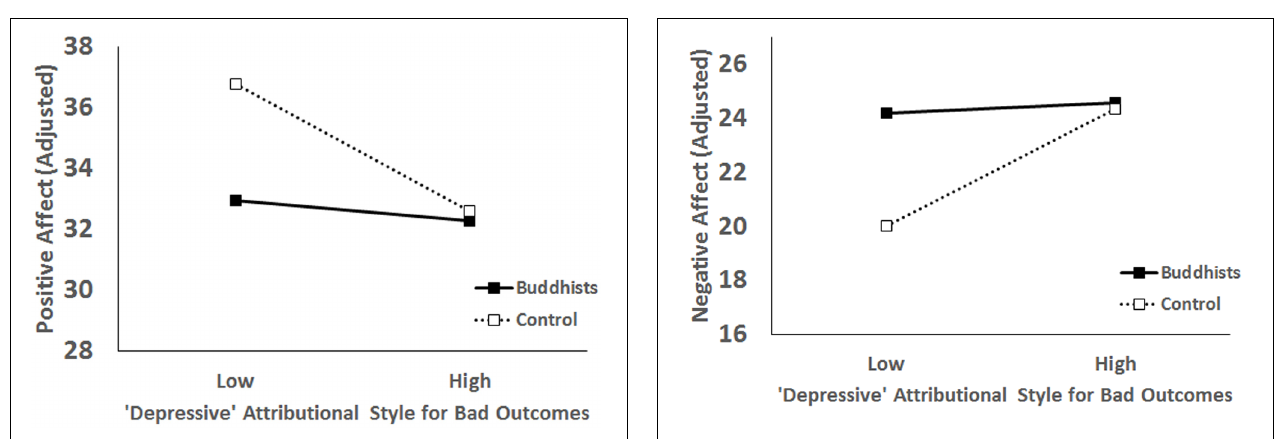
significant in the Buddhist group, B = − 0.02, t = − 0.57, p = 0.57, 95% CI [ − 0.08–0.04] ( Figure 2 ).